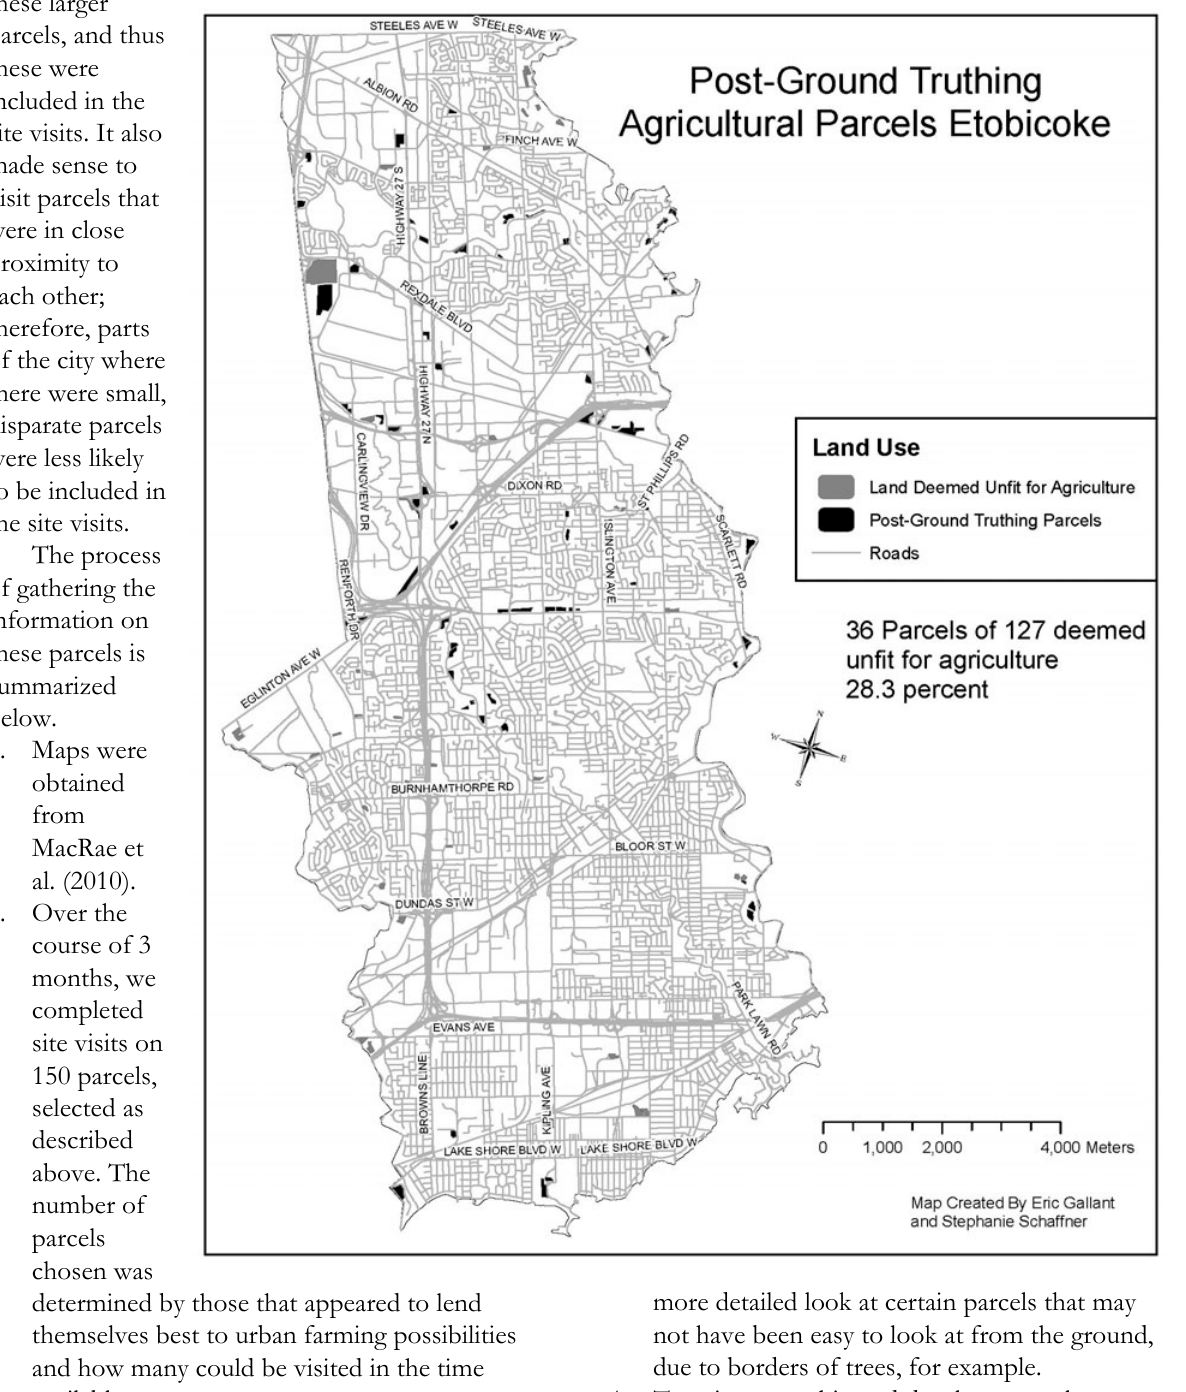
Figure 1. Post-Ground Truthing Agricultural Parcels in Etobicoke the majority